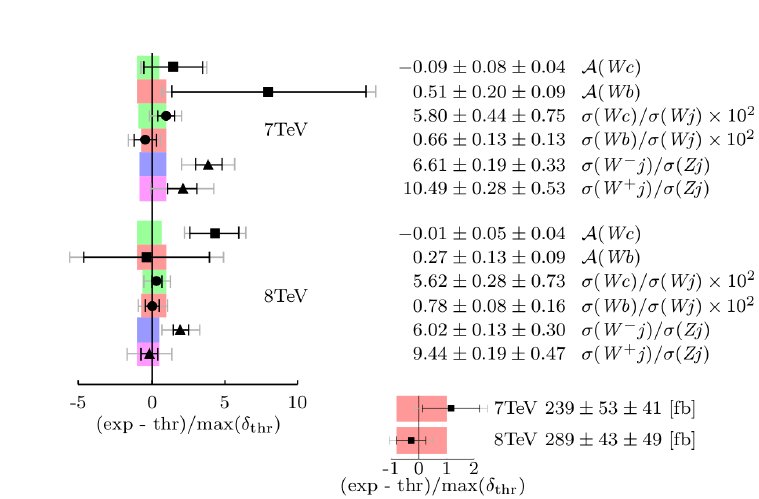
Figure 3: Comparison of W + b / c results and theoretical predicitons [ 18 ] . The the- ory uncertainties are given by the colored bands, while the measurements are shown by points with errorbars. The inner error bar shows the statistical uncertainty, while the outer errorbar shows the total uncertainty. The theoretical predictions were cal- culated at NLO using MCFM [ 19 ] and the CT10 NLO PDF set [ 20 ] . The theory un- certainty includes contributions from PDF, scale, and strong coupling uncertainties with the PDF uncertainty